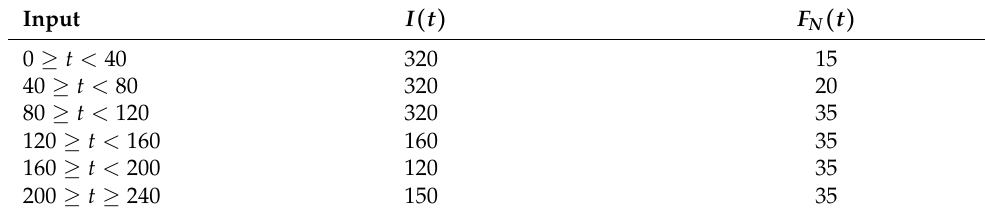
Table A6. Initial RTO